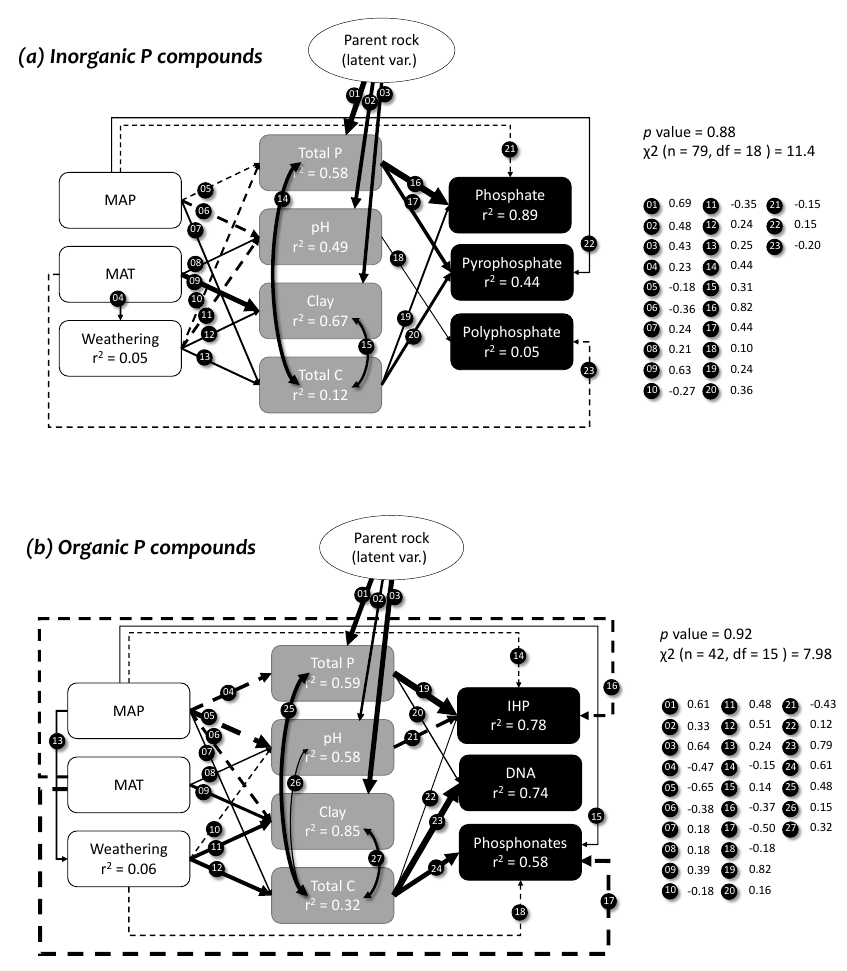
Figure 7. Path analysis describing the direct and indirect effects of the main environmental predictors of soil inorganic and organic P compounds (mgkg − 1 ) in NaOH-EDTA extract as influenced by edaphic and climatic drivers on natural ecosystems. Solid and dashed lines represent positive and negative relationships, respectively. Soil organic and inorganic P compounds were in mgkg − 1 , and the other variables followed units described on Figs. 2 and